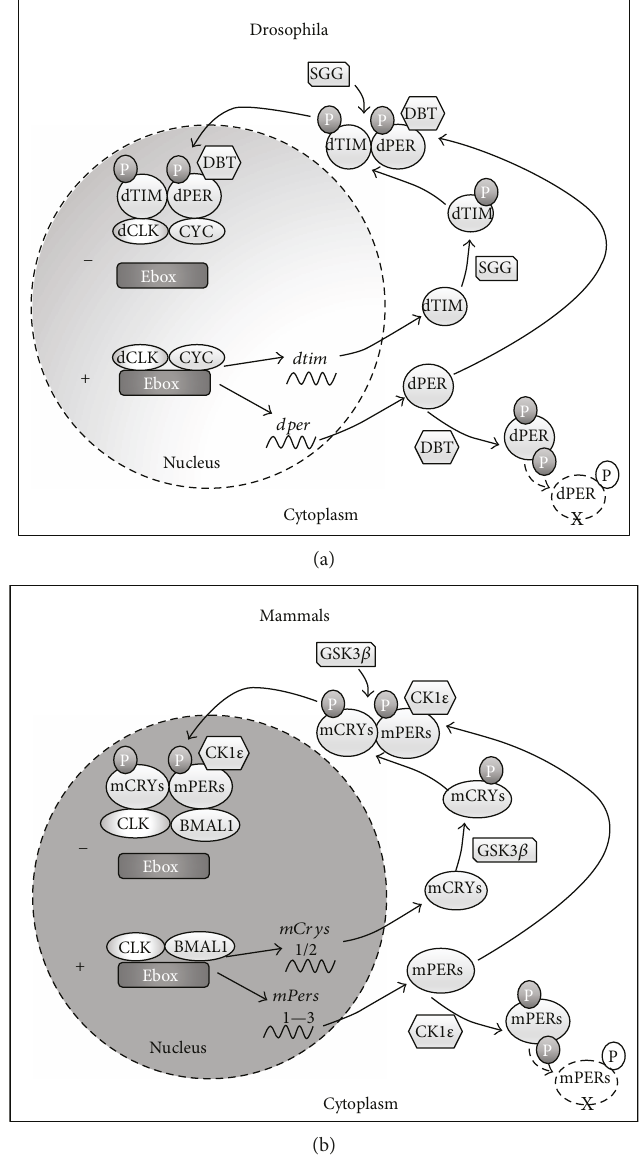
Figure 4: The molecular clocks of Drosophila (a) and mammals (b). (a) In Drosophila , dCLK and CYC form a dimer, which binds to the E boxes in the promoter of per and tim as well as to other clock-controlled genes to facilitate transcription. PER and TIM proteins form a complex and translocate into the nucleus providing negative feedback to inhibit dCLK-CYC DNA binding. Phosphorylation mediated by DBT and SGG regulates protein – protein interactions, nuclear translocation, and degradation. (b) In mammals, the transcription factors BMAL1 and CLK form a dimer that binds to E boxes in the promoter of mPer and mCry . mPER and mCRY proteins form dimers, enter the nucleus, and inhibit the BMAL1-CLK activity. Phosphorylation mediated by CK1 and GSK3 regulates protein – protein interactions, nuclear translocation, and